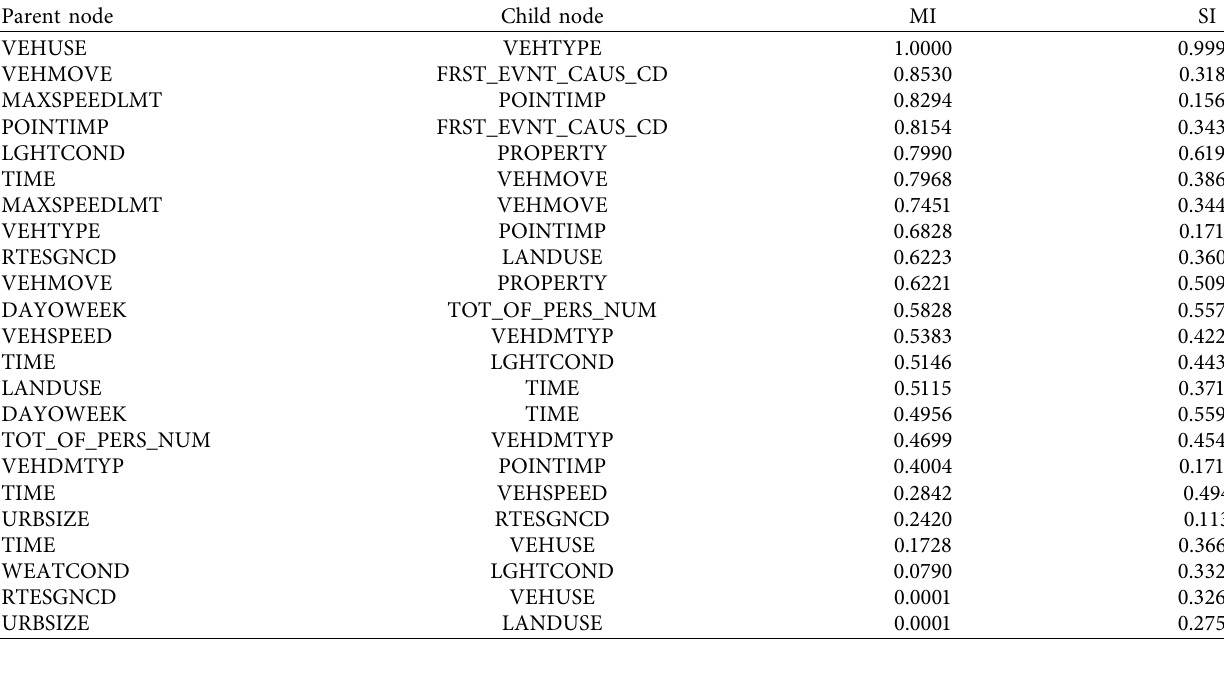
Table 3: Te MI and SI in the parking lot Bayesian network.